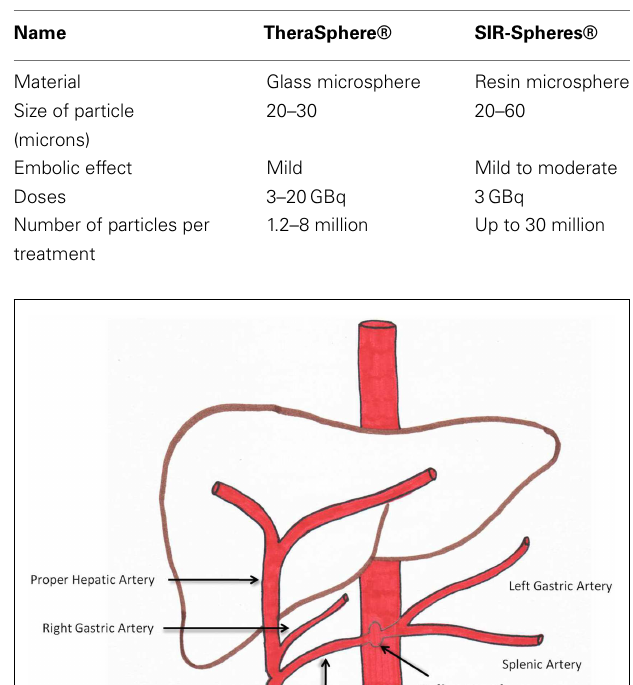
Table 1 |Yttrium-90 microsphere devices .